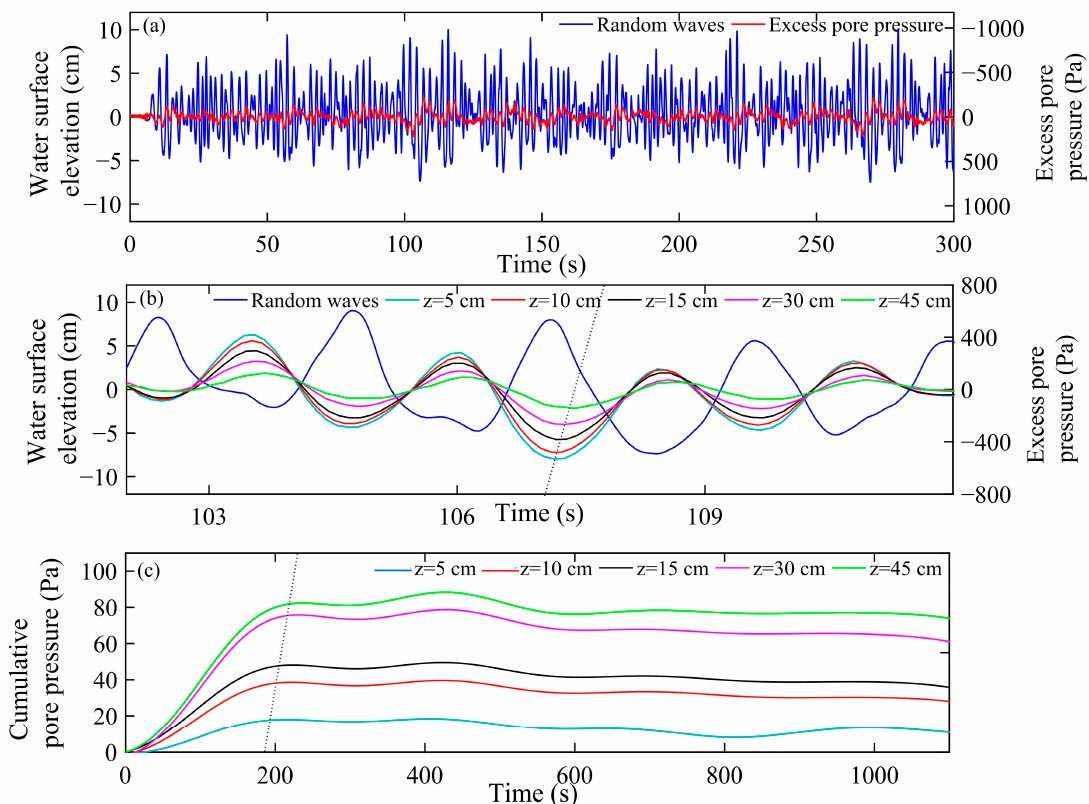
Figure 3. Time-series of random waves, excess pore pressure, and cumulative pore pressure during the experiment process: ( a ) time-series of random waves (blue curve) and excess pore pressure at a depth of 10 cm (red curve); ( b ) time-series of random waves (blue curve) and excess pore pressure at different depths (other colors, detailed view); ( c ) cumulative pore pressure at different depths over time, with the dashed line indicating the time taken to reach the first crest at distinct depths.